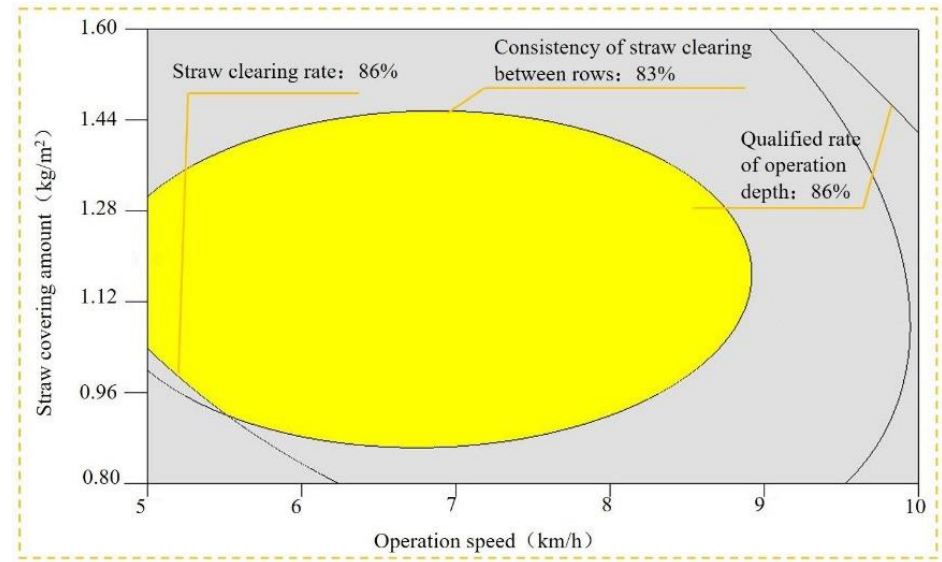
Figure 9. Parameter optimization results.